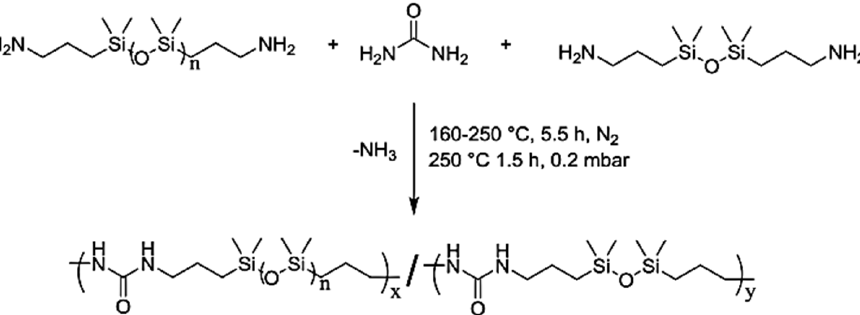
Figure 21. Synthesis of isocyanate-free, segmented, poly(dimethyl siloxane) (PDMS)-containing polyureas with bis(3-aminopropyl)tetramethyldisiloxane (BATS) as a chain extender via melt poly- condensation in the absence of solvent and catalyst (poly(PDMS1.7kU) x -co-poly(BATSU) Y ). From reference [23].